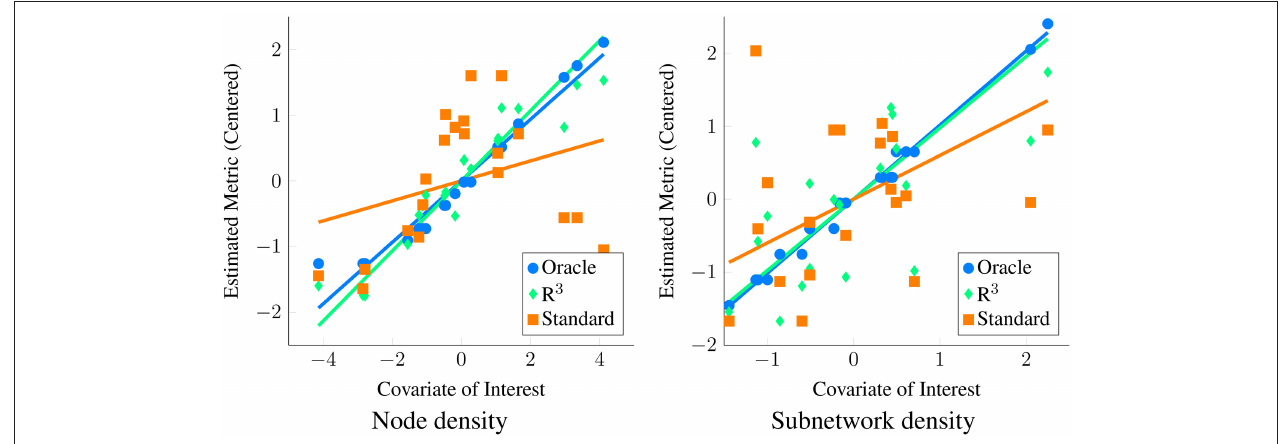
FIGURE 1 | Motivation for new statistical framework R 3 . Here, we simulate covariate effects on the metric of interest, namely the degree centrality or node density (left) and subnetwork density (right) with ( p = 50 , n = 20 , t = 200) . We illustrate covariate effects in the ideal scenario where network metrics are known perfectly in blue. Unfortunately, in functional connectivity networks, statistical errors in estimating graphical models are inevitable and these propagate to estimates of network metrics. As a result, when we estimate node and subnetwork density for each subject and conduct tests for covariate effects using standard F -tests, we fail to see a clear relationship between metrics and covariate of interest (orange) using linear regression. This loss of statistical power occurs when standard test statistics assume that estimates of density are correct. In contrast, when we account for errors in graph estimation and selection using R 3 test statistics (green), we have greater statistical power to detect covariate effects on density metrics. Algorithmic details of the R 3 approaches can be found in Section 2.